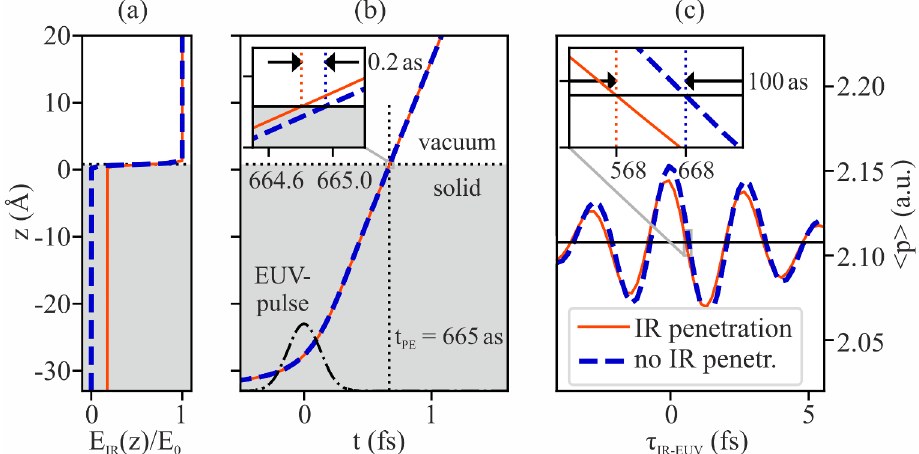
Fig. 1. (a): z-component of the inhomogeneous electric field of the IR pulse in z-direction. Blue dashed lines mark the case without streaking field penetration and red solid lines mark the case with 18 % IR field amplitude penetration. (b): Transient position expectation value of a photoelectron wave z packet generated at − 32.6 Å by a 300 as EUV pulse (black dash-dotted line). The intersection of with the surface (horizontal black dotted line at z s = 0.78 Å) corresponds to the propagation time of 〈 〉 the wave packet to the surface t PE (vertical black dotted line). The inset shows z close to the surface. (c): Corresponding momentum expectation values extracted from streaking spectrograms for 〈 〉 penetrating and non-penetrating streaking fields. The absolute delay deviation is shown in the inset. The horizontal black solid line marks p without IR 〈 〉